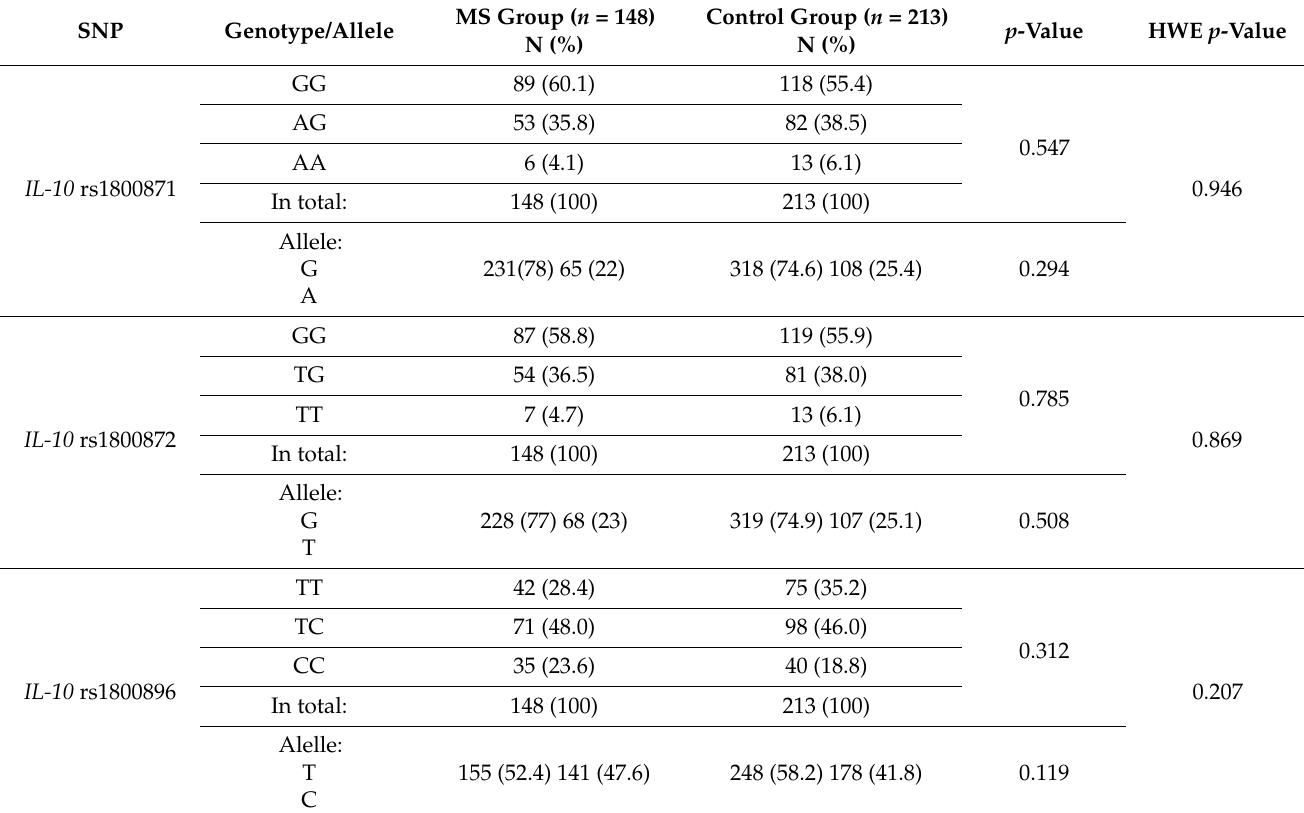
Table 2. IL-10 rs1800871, rs1800872, and rs1800896 genotype and allele frequencies in multiple sclerosis patients and control